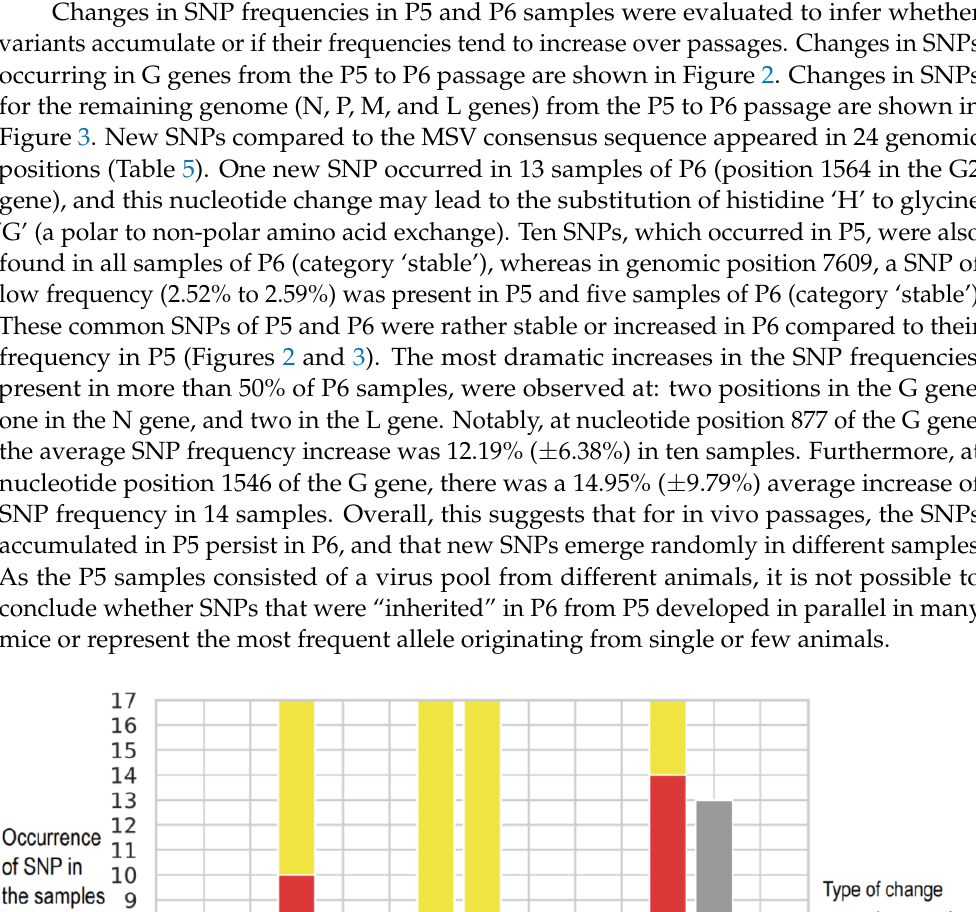
Figure 3. Changes in SNPs occurring in N, P, M, and L genes of SPBN GASGAS genome from P5 to P6 passage. Genomic position is indicated on X axis. Frequency of each SNP in samples from P6 was compared to P5 as basis, i.e., increased: P6 frequency > P5 frequency + 5% in P5, stable (±5% change in frequency), decreased: P6 frequency < P5 frequency — 5%, new: SNP occurring just in P6.